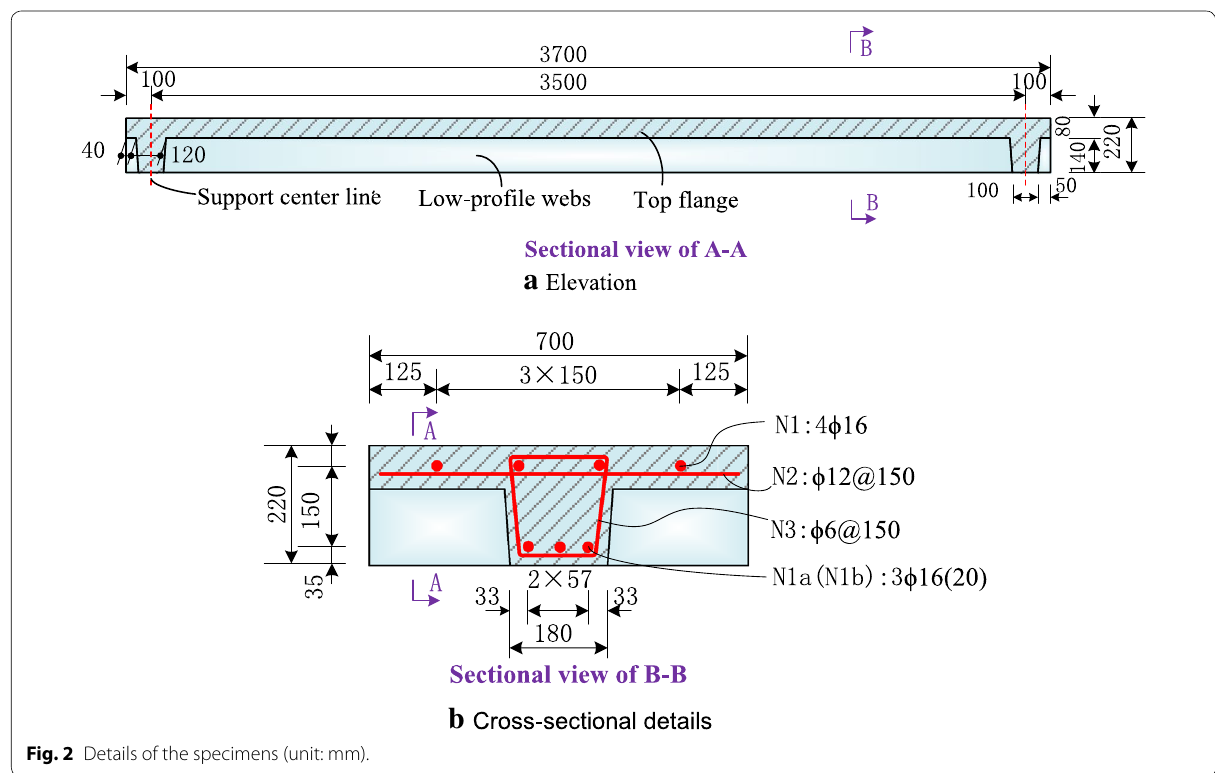
Fig. 2 Details of the specimens (unit: mm).